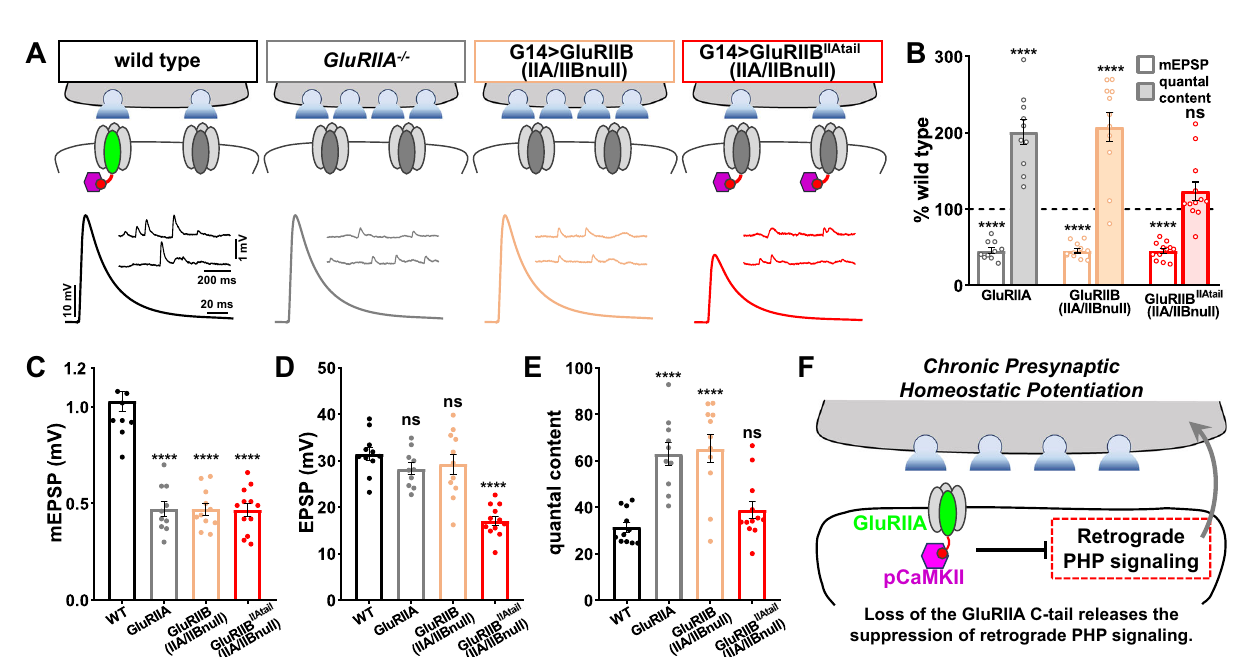
Fig. 8 | Retrograde PHP signaling is occluded when pCaMKII is recruited to NMJslackingGluRAreceptors. Α Schematicandrepresentativetracesillustrating that retrograde PHP signaling is occluded at NMJs containing chimeric GluRB receptors, while PHP is robustly expressed at NMJs containing wild-type GluRB receptors. Note that while mEPSP amplitudes are similarly reduced at NMJs con- taining only GluRB receptors, the presynaptic release does not increase when pCaMKII is recruited to NMJs by chimeric GluRB receptors. B Quanti fi cation of mEPSP and quantal content values in the indicated genotypes normalized to wild- type values (wild type: n =12; GluRIIA − / − , n =10, p <0.0001 for mEPSP, p <0.0001 for QC; G14>GluRIIB: n =11, p <0.0001 for mEPSP, p <0.0001 for QC; G14> GluRIIB IIAtail : n =12, p <0.0001formEPSP, p =0.4908forQC). C – E Quanti fi cationof average mEPSP amplitude ( C ), EPSP amplitude ( D ), and quantal content values ( E )